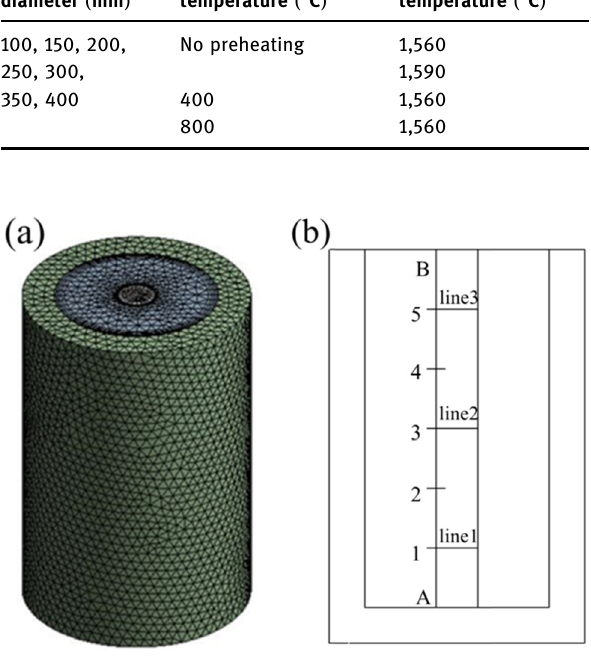
Figure 4: A steel ingot and a steel ingot mold with a core diameter of 350 mm and a molten steel coating thickness of 600 mm: ( a ) grid division; ( b ) temperature extraction